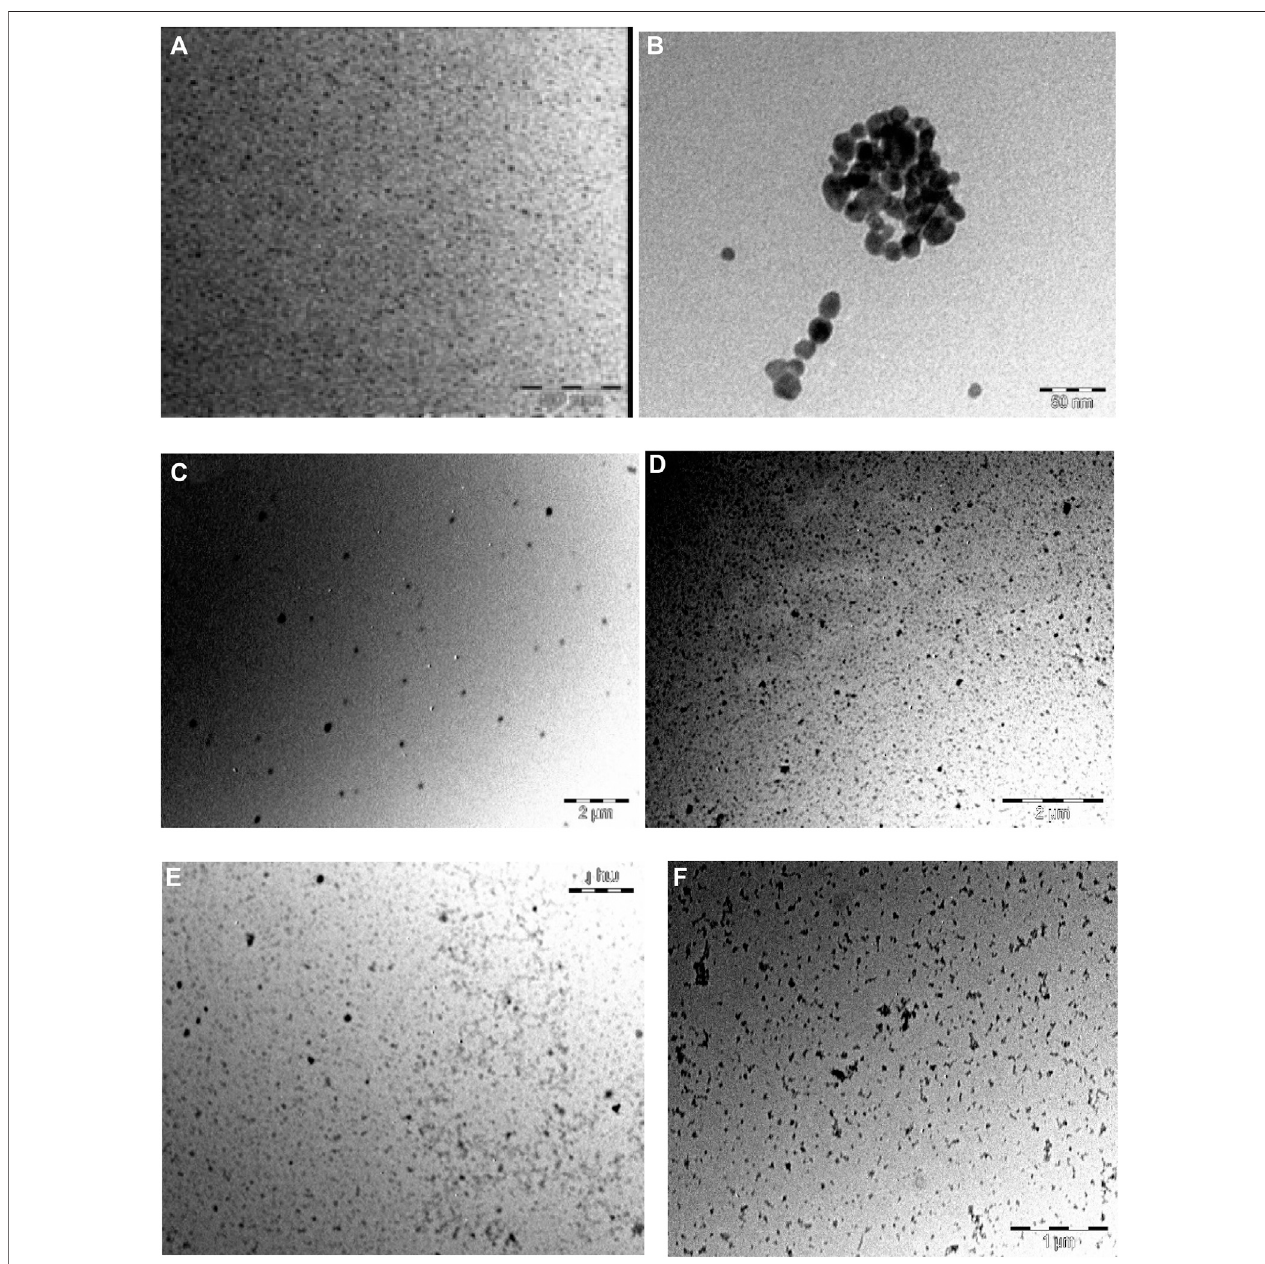
FIGURE 4 | TEM images of (A) DNDs, (B) Ag NPs, (C) 1 -DNDs@Ag, (D) 2 -DNDs@Ag, (E) 3 -DNDs@Ag and (F) 4 -DNDs@Ag (showing the size and morphology).